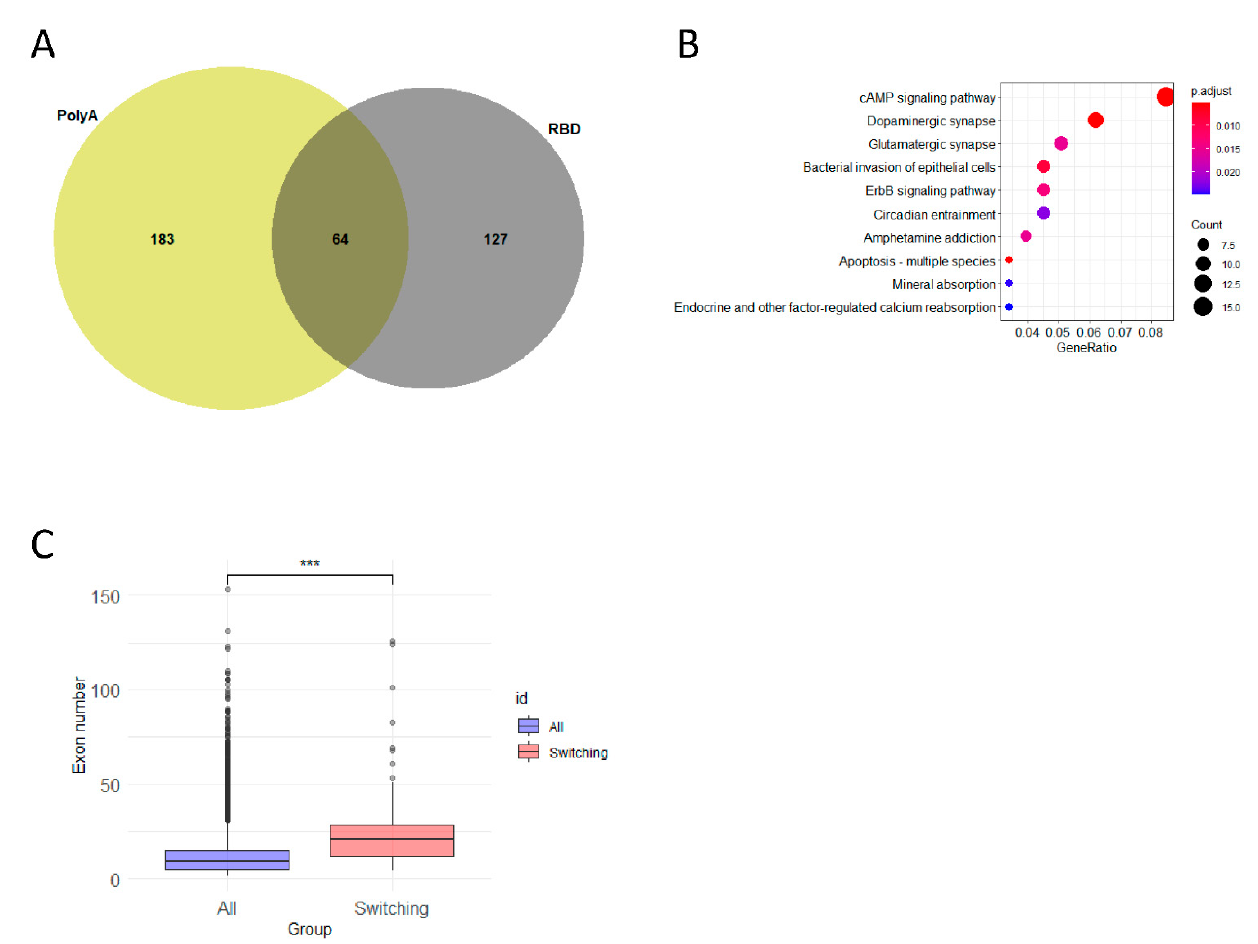
Figure 7. ( A ) Intersection between genes undergoing differential transcript usage (DTU) in PolyA (VH vs. DH) and RBD (VH vs. DH) datasets. ( B ) Top 10 KEGG categories for genes that fell into intersection from ( A ). ( C ) Comparison of mean exon numbers between DTU and non-DTU genes. ***, result is significant with p < 0.05 (Mann-Whitney test).